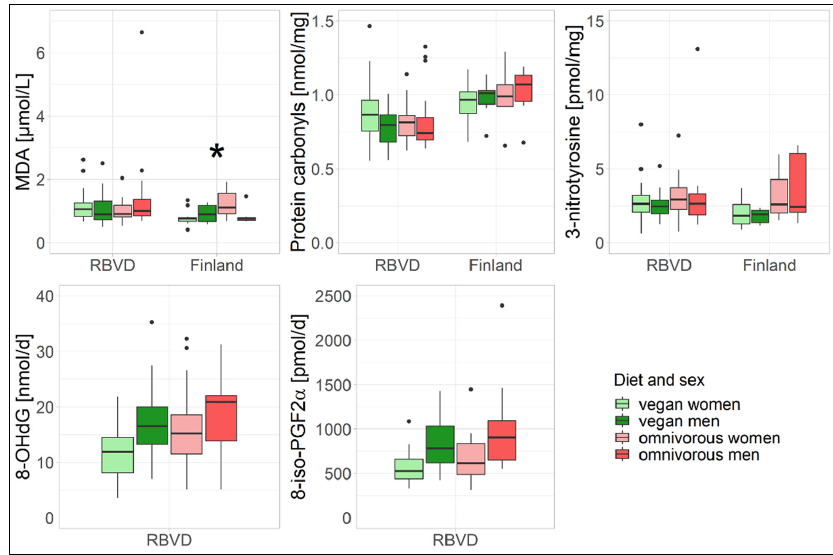
Figure 3. Boxplots of the oxidative damage biomarkers stratified by dietary group and sex in the RBVD and the Finnish study. Dots represent extreme values. * p < 0.05; p -values of the interaction term of diet with sex from Tables S6 and S7 are reported.